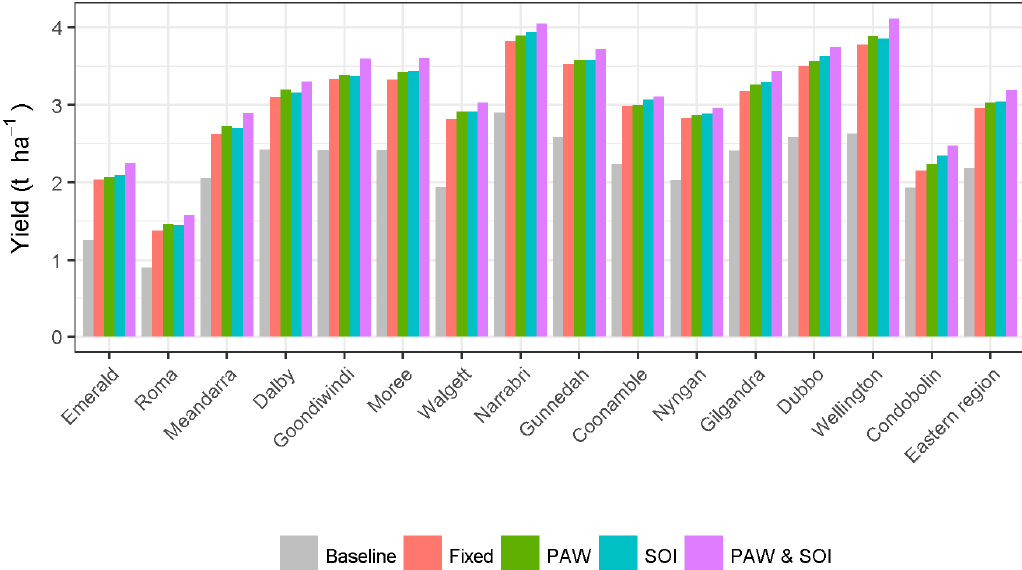
Figure 5. Simulated mean yields for the baseline, fixed adaption, and all the studied tactical adaptation scenarios related to pre-sown soil water and SOI forecast. The baseline corresponds to simulated yield for a medium-season cultivar Janz sown at semi-optimum sowing date (21 May) with no extra nitrogen input. The fixed adaptation scenario corresponds to optimised genotype and management across all years for each site. The three tactical adaptation scenarios include specific adaptation to soil PAW (plant available water) groups, SOI classes, and PAW & SOI groups. These adaptations correspond to optimised genotype and management for each PAW group and/or SOI class. SOI phases were determined in March–April, prior to sowing.